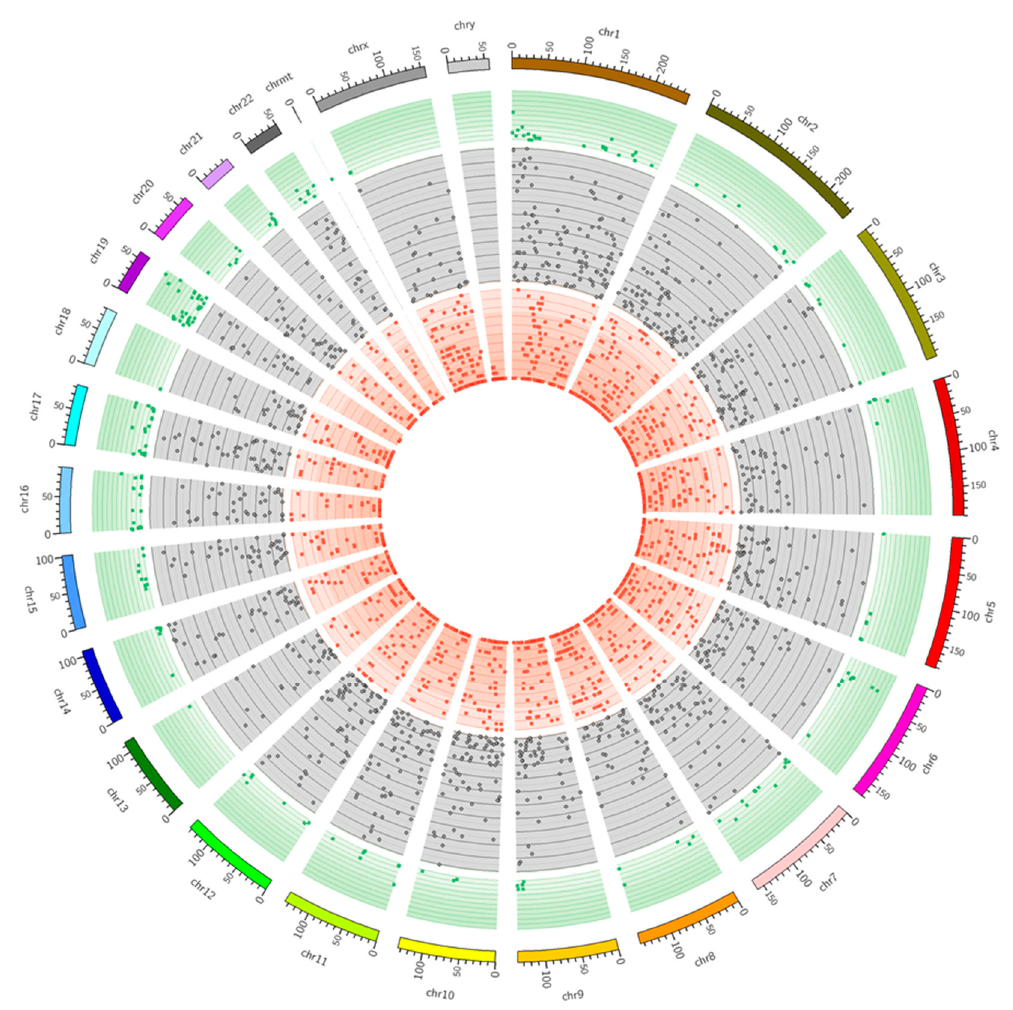
Figure 6. Distribution of SNVs detected on the physical map of the human genome designated by rMATS-DFR; scale in Mb. The red circle indicates the regions with small numbers (< 15) of SNVs per 1 Mb. The gray circle indicates the regions with medium numbers (>15 and <100) of SNVs. The green circle indicates the richest regions of SNVs (>100).